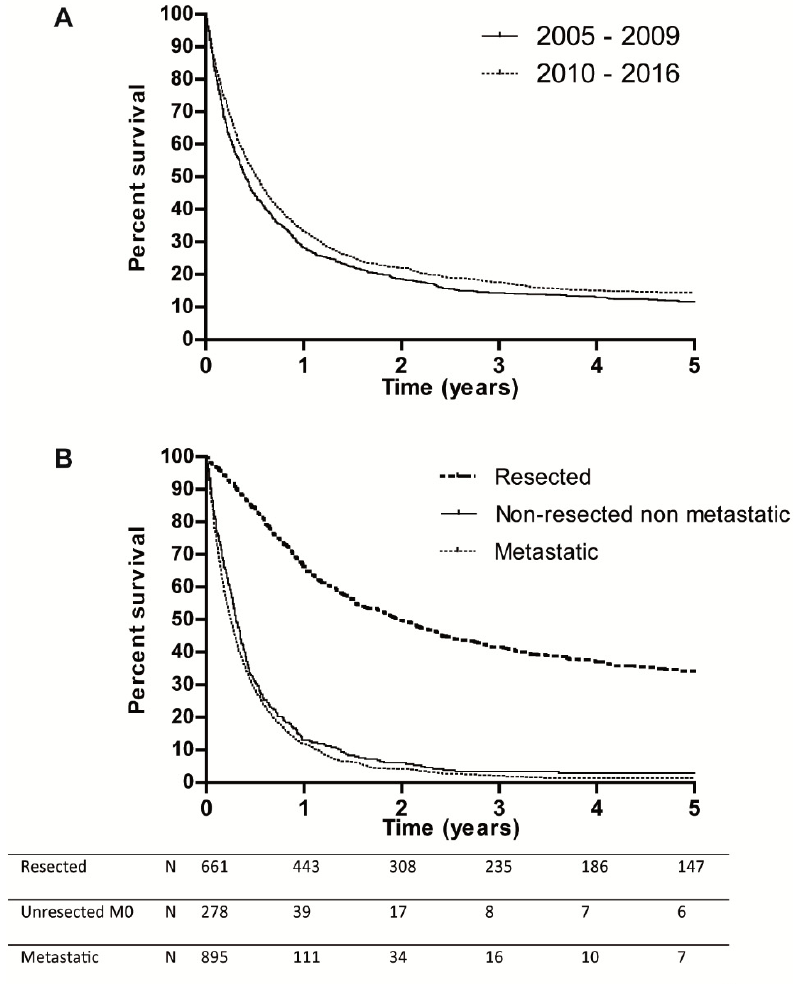
Figure 3. ( A ): Survival according to time period. ( B ): Survival according to disease Figure 3. A : Survival according to time period. B : Survival according to disease stage.